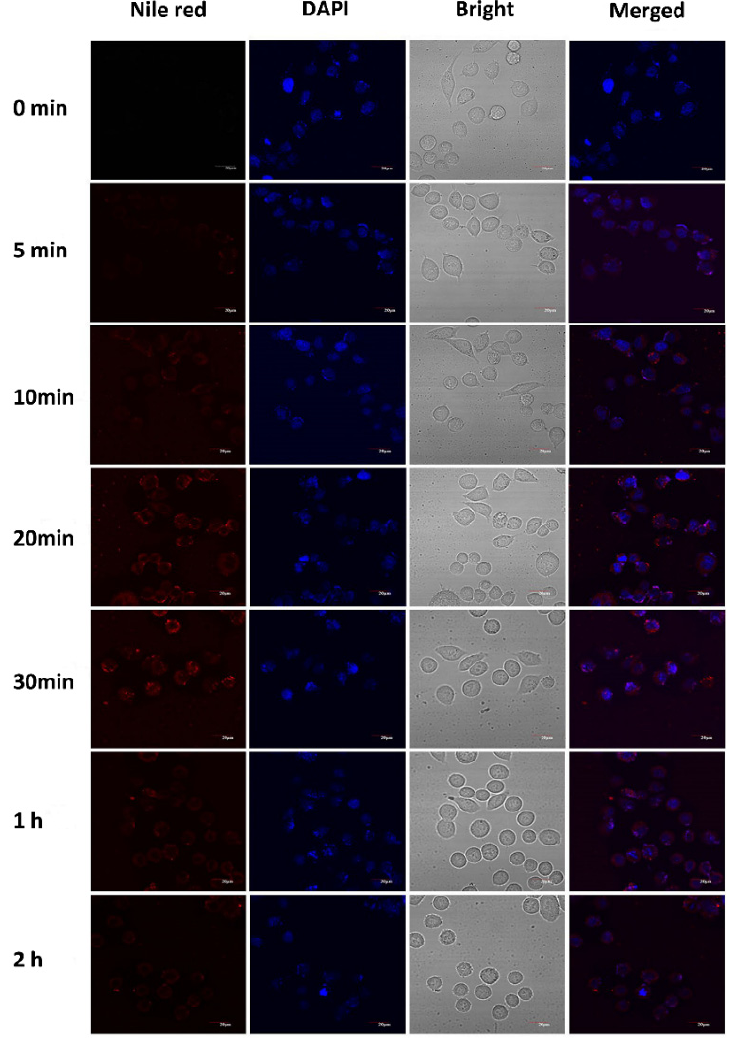
Figure 6. Cellular uptake observed by CLSM of cultured HepG2 after treatment with CAS-loaded nanoemulsions. Cell nuclei were stained with DAPI for visualization in blue, and nanoemulsions were dyed with Nile red in red.